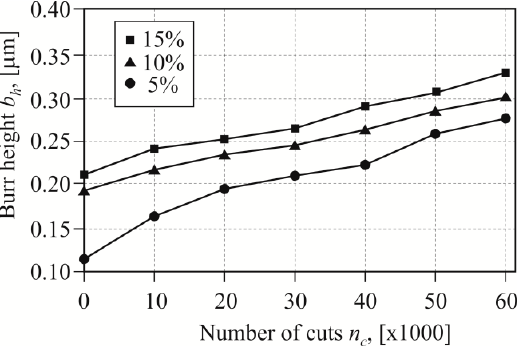
Figure 13. Influence of the number of cuts on the size of the burr at the fifth measurement point (Figure 7b).